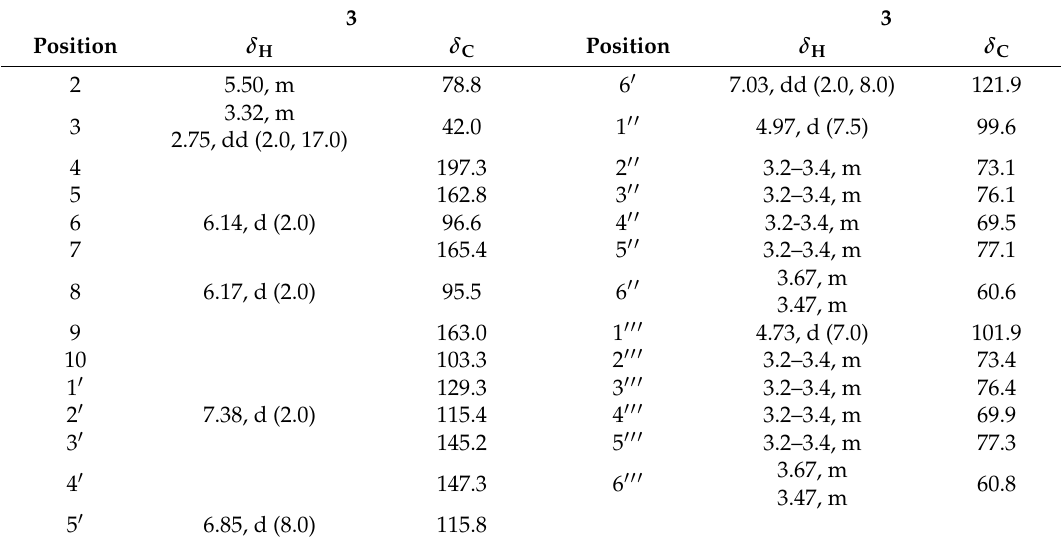
Figure 4. Key HMBC correlations of compound 3.